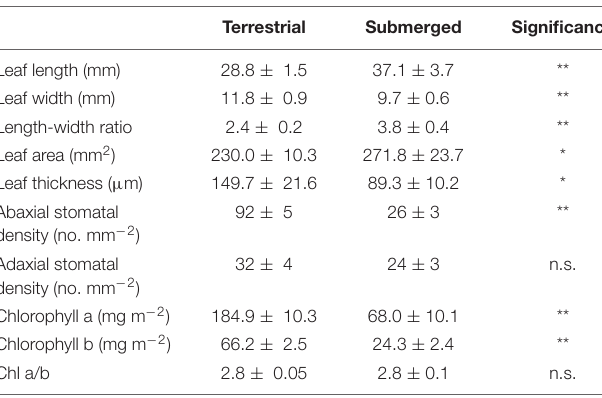
TABLE 1 | Leaf morphological characteristics in terrestrial and submerged leaves of Hygrophila polysperma